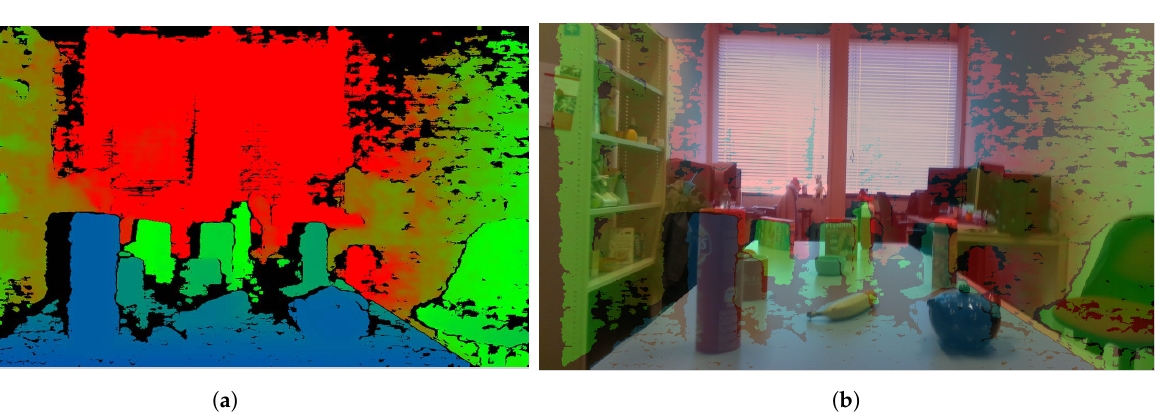
Figure 6. ( a ) The captured depth image: the red rectangle shows left invalid depth band. ( b ) Misalignment of color- and-depth image pairs: the images are generated when the distance between the object and camera is near, showing large